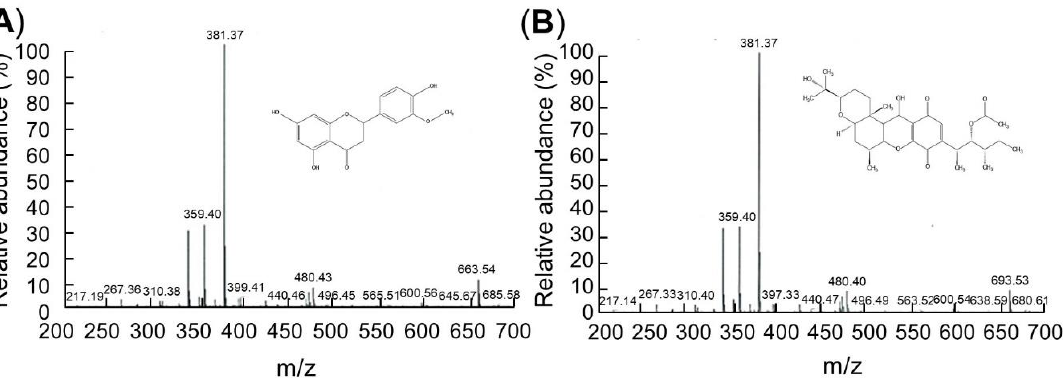
Figure 2. C7 and C9 LC / MS data. The flow rate was consistently 50 µ L / min with a 320 ◦ C capillary temperature and 49 V of capillary voltage. ( A ) Chrysoeriol 7 (C7). Mass: 267.36 and 381.37 m / z , 5,7-dihydroxy-2-(4-hydroxy-3-methoxyphenyl)chromen-4-one, C 16 H 12 O 6 , molecular weight = 300.26 g / mol. ( B ) Cochlioquinone 9 (C9). Mass: 381.38 and 480.40 m / z , (3R)-9-[(1S,2R,3S)-2-acetyloxy-1,3-dimethylpentyl]-1,2,3,4a β ,5,6,6a,12,12a β ,12b-decahydro-12 β -hydroxy-3 α -(1-hydroxy-1-methylethyl)-6a α ,12b α -dimethylpyrano[3,2-a]xanthene-8,11-dione, C30H44O8, molecular weight = 532.7 g / mol.